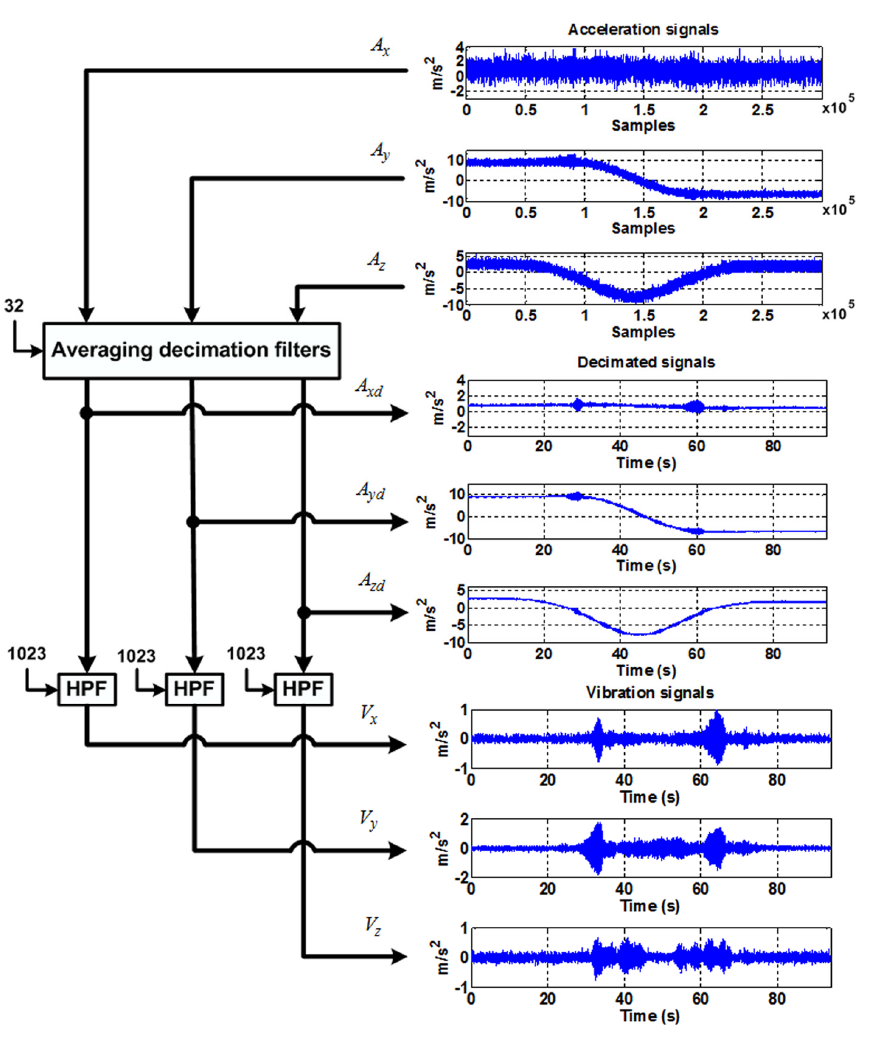
Figure 7. Vibration-parameters estimation methodology used to separate vibrations from the original accelerometer